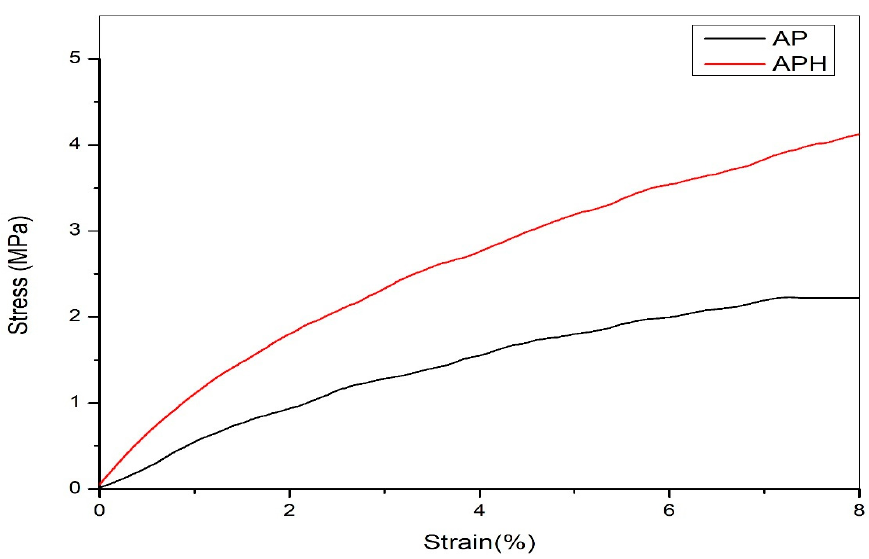
Figure 4. Stress Strain graph of AP and APH film.